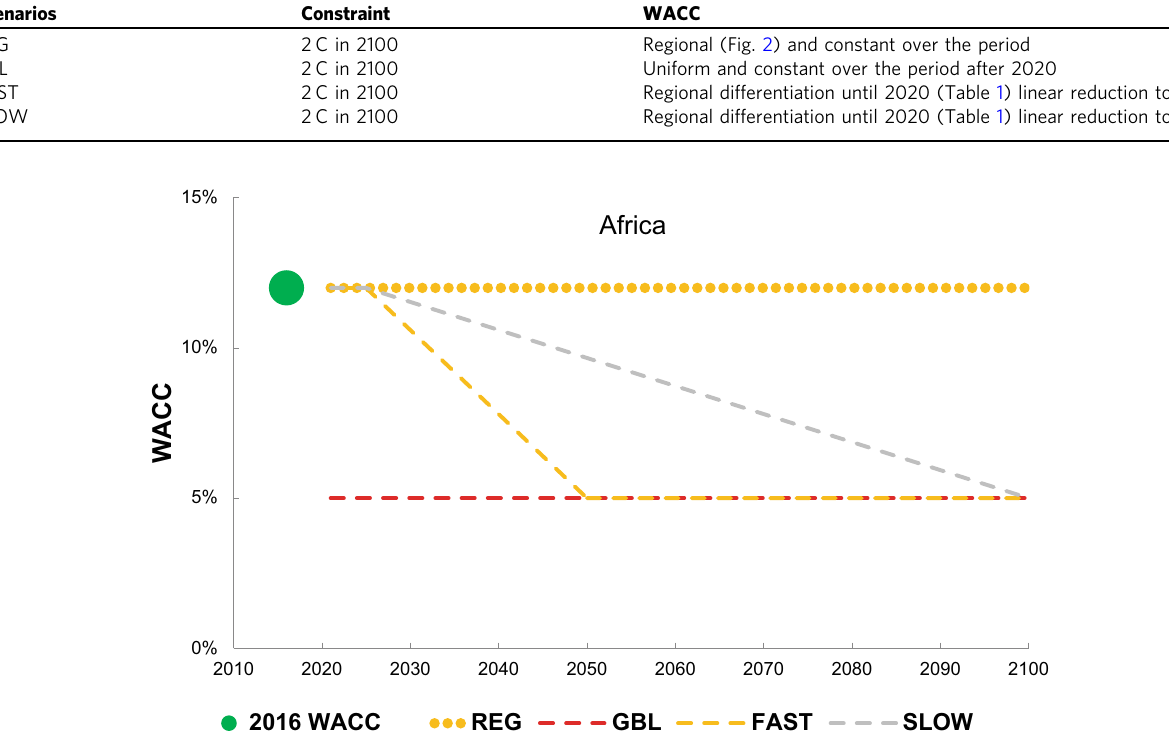
Fig. 7 Evolution of the low-carbon WACC for Africa under different scenarios. The fi gure shows the trajectory of low-carbon WACC for a selected developing economy (Africa) under the four scenarios considered in the